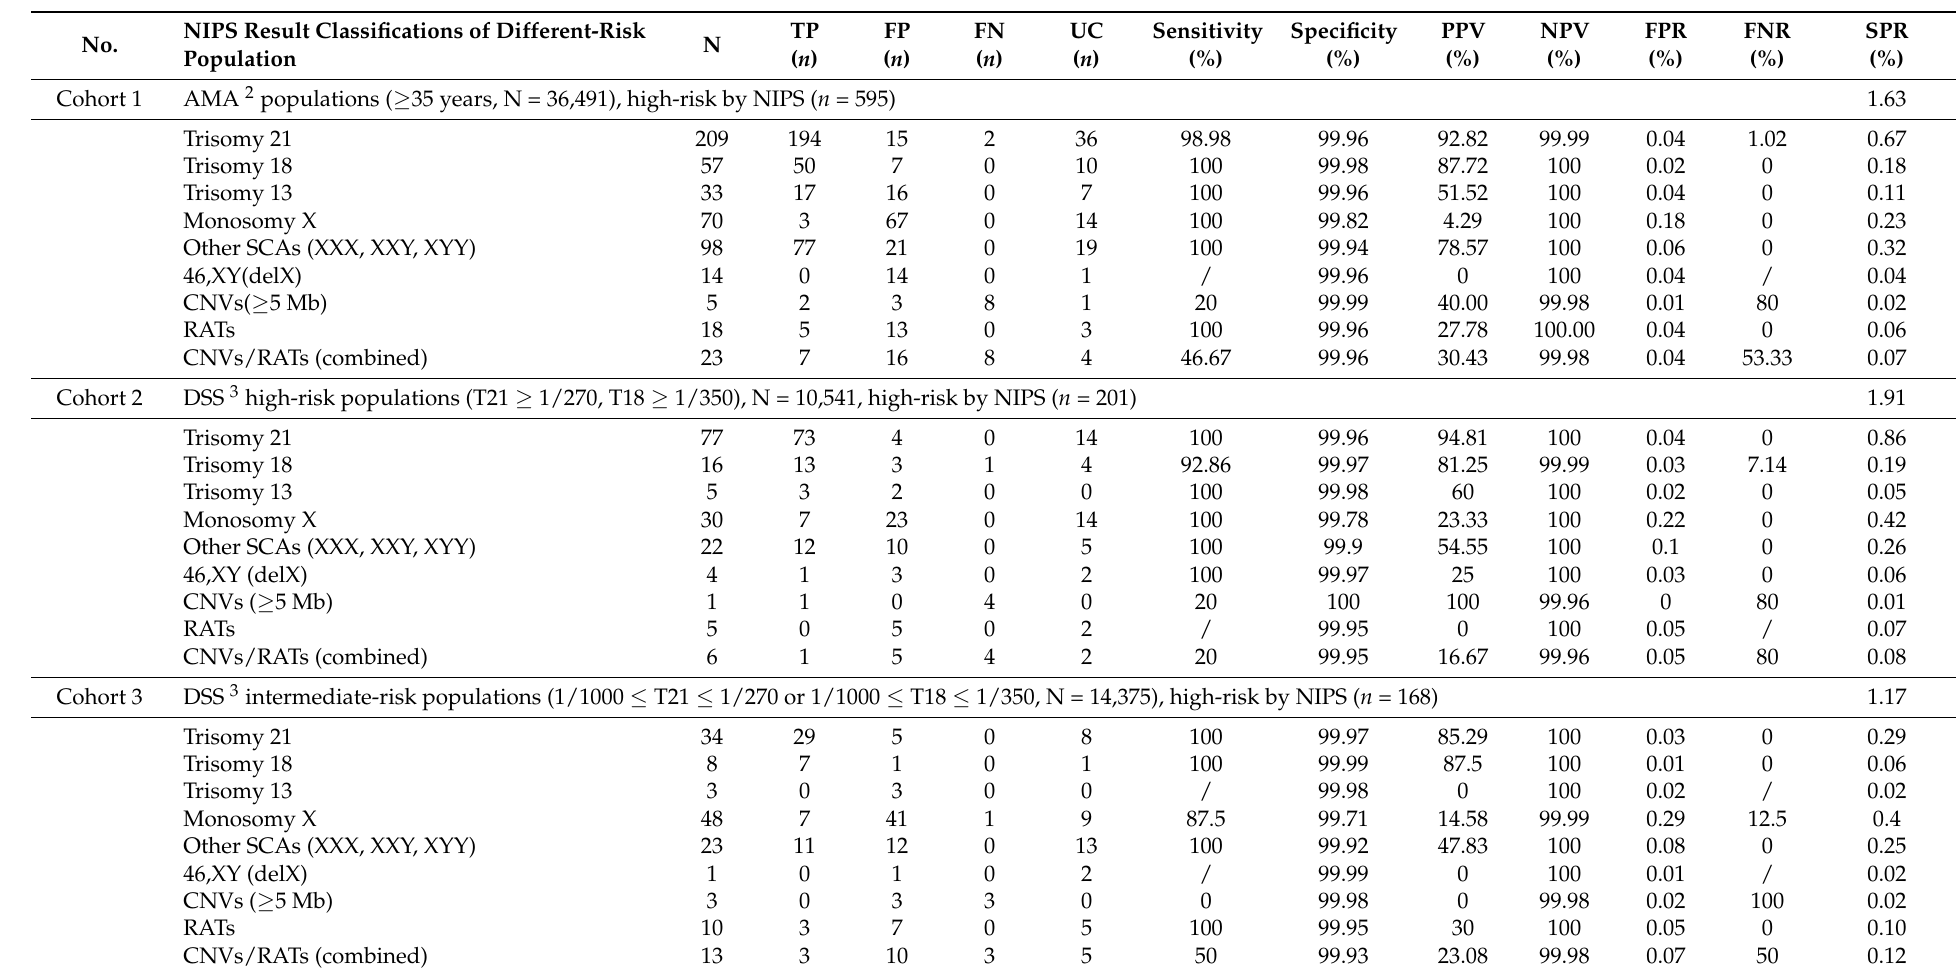
Table 4. Performance and classifications of NIPS in different risks pregnancy cohort groups 1